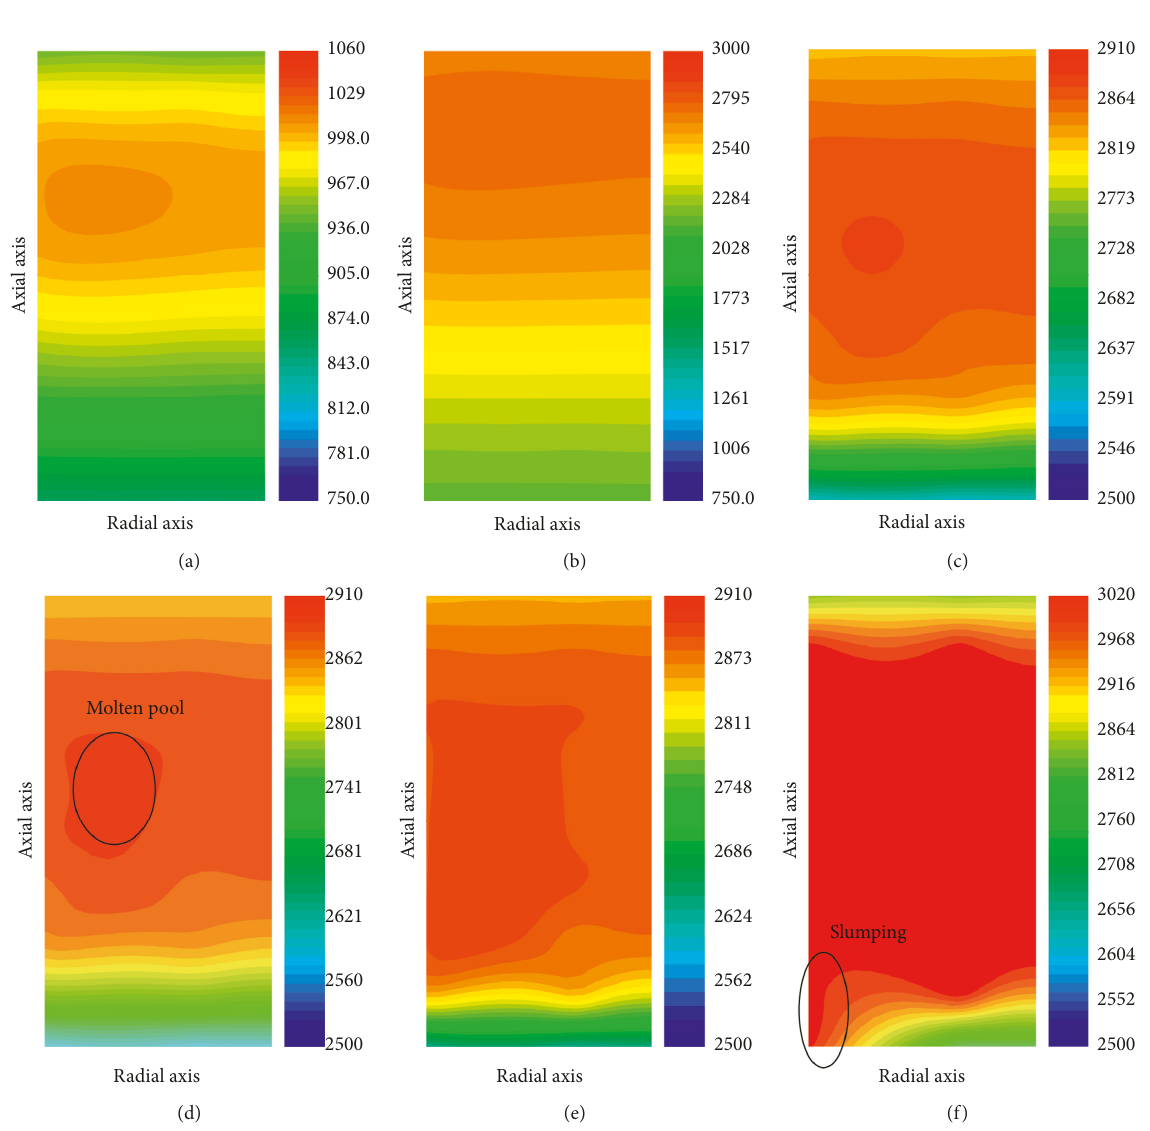
Figure 5: Temperature distribution of the core in no depressurization. (a) Partial oxidation at 7710s. (b) Extensive oxidation at 10500s. (c) Beginning to melt at 12075s. (d) Molten pool formation at 12,090s. (e) Molten pool expanding at 12,300s. (f) Corium relocation at